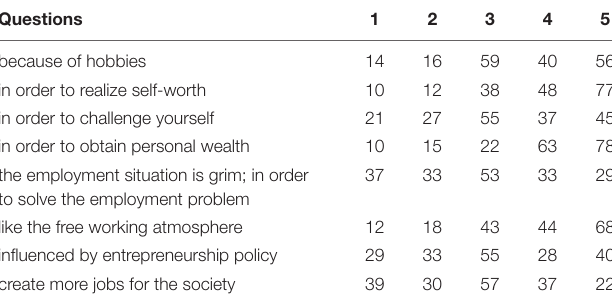
Frontiers in Psychology |